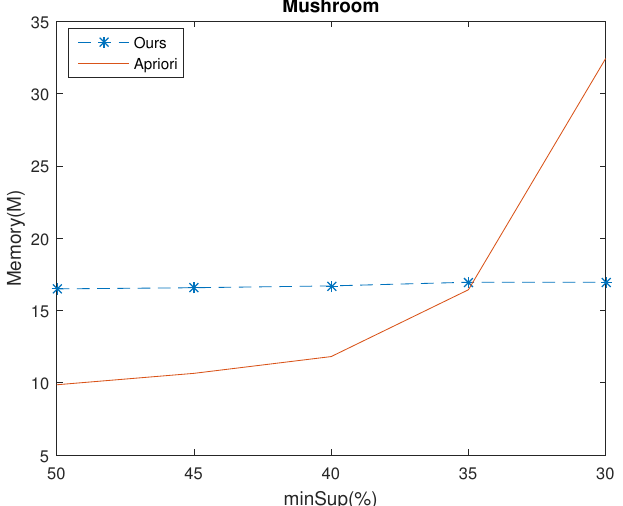
Figure 10. Memory usage of the two algorithms in Mushroom dataset for various minSup values.